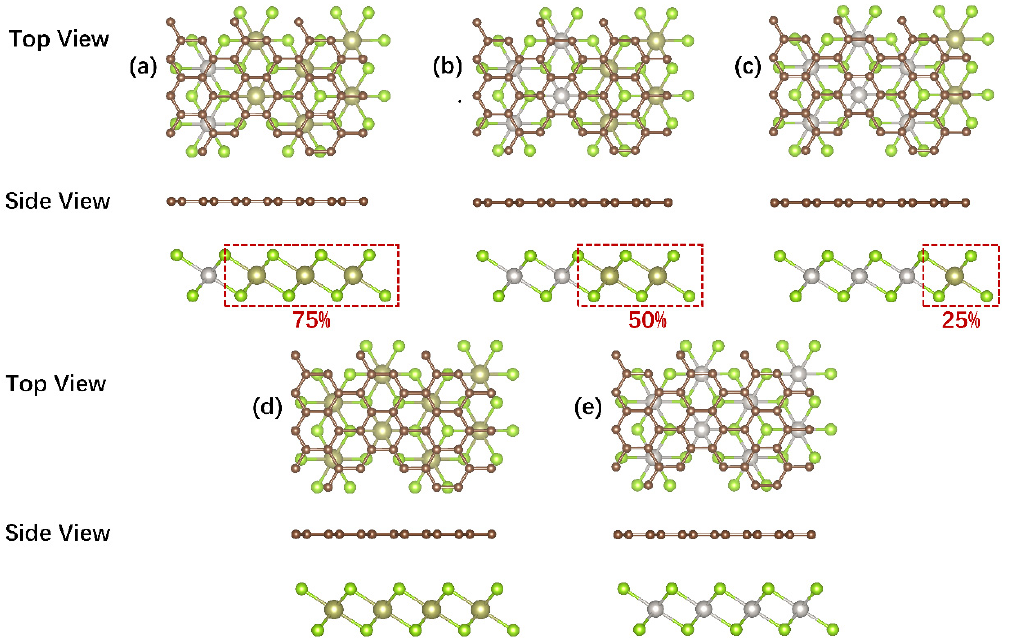
Figure 1. Top view and side view of stable configurations of ( a ) Gr@Pt 1 Hf 3 , ( b ) Gr@Pt 2 Hf 2 , ( c ) Gr@Pt 3 Hf 1 , ( d ) Gr@HfSe 2 , and ( e ) Gr@PtSe 2 . The brown, dark green, grey, and light green balls represent C, Hf, Pt, and Se atoms, respectively. The different partial (25%, 50%, and 75%) substitutions of bidirectional heterostructures are shown by the red, dashed-line square. Table 1. The lattice constants (Å), bond lengths (Å) of Pt–Se and Hf–Se, and lattice mismatch ratios of Gr@Pt n Hf 4 − n .